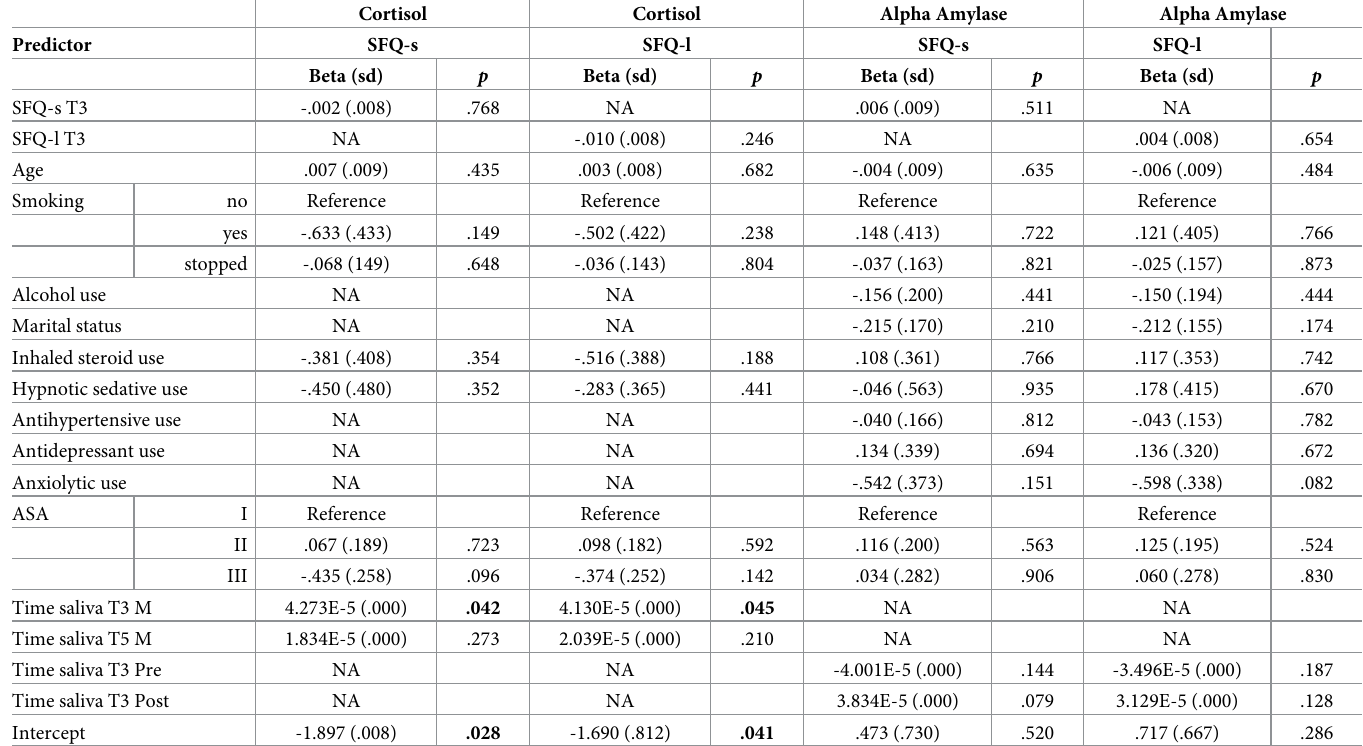
Table 2. Multivariate assessment of the association between surgical fear and salivary cortisol /